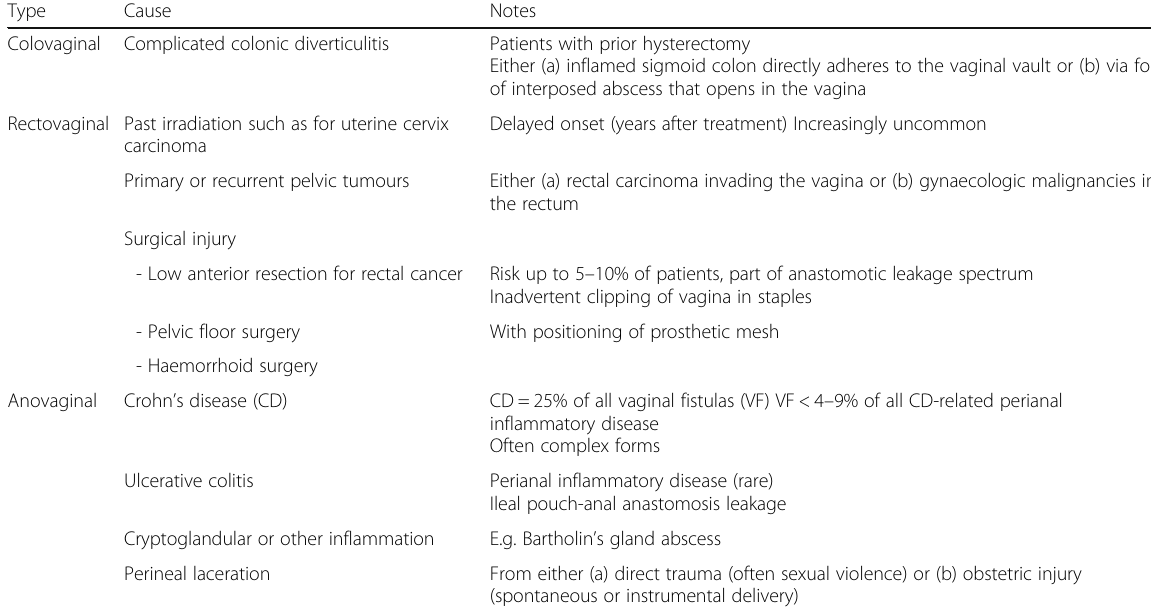
Table 1 Categorisation, causes and mechanisms of entero-vaginal fistulas Type